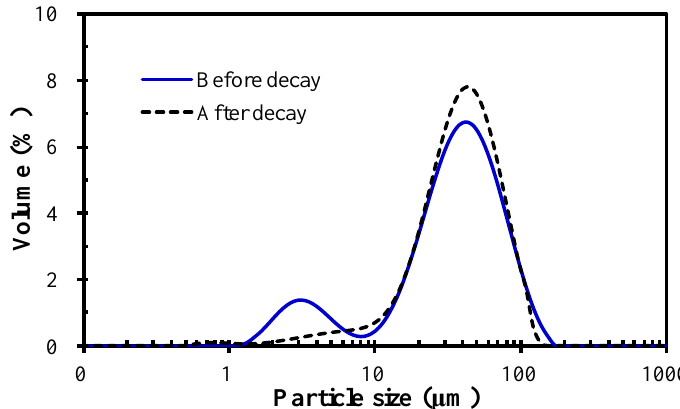
Figure 4. PSD of the microalgae in the MPBR before and after decay.